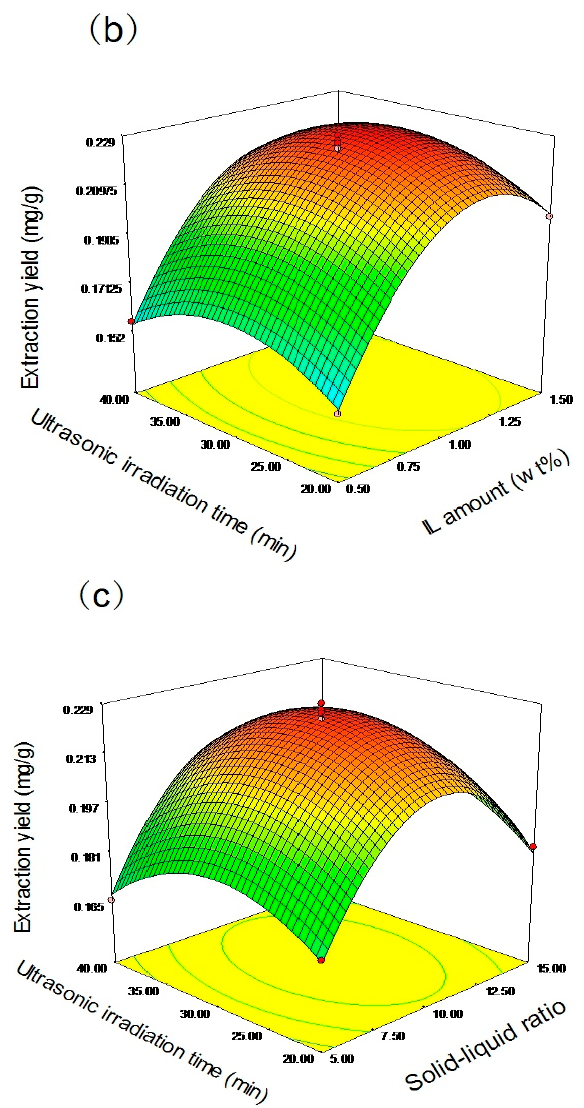
Figure 3. Response surface curves for the extraction of paclitaxel showing interaction between ( a ) IL amount (wt %) and solid–liquid ratio; ( b ) IL amount (wt %) and ultrasonic irradiation time (min), and ( c ) solid–liquid ratio and ultrasonic irradiation time (min).